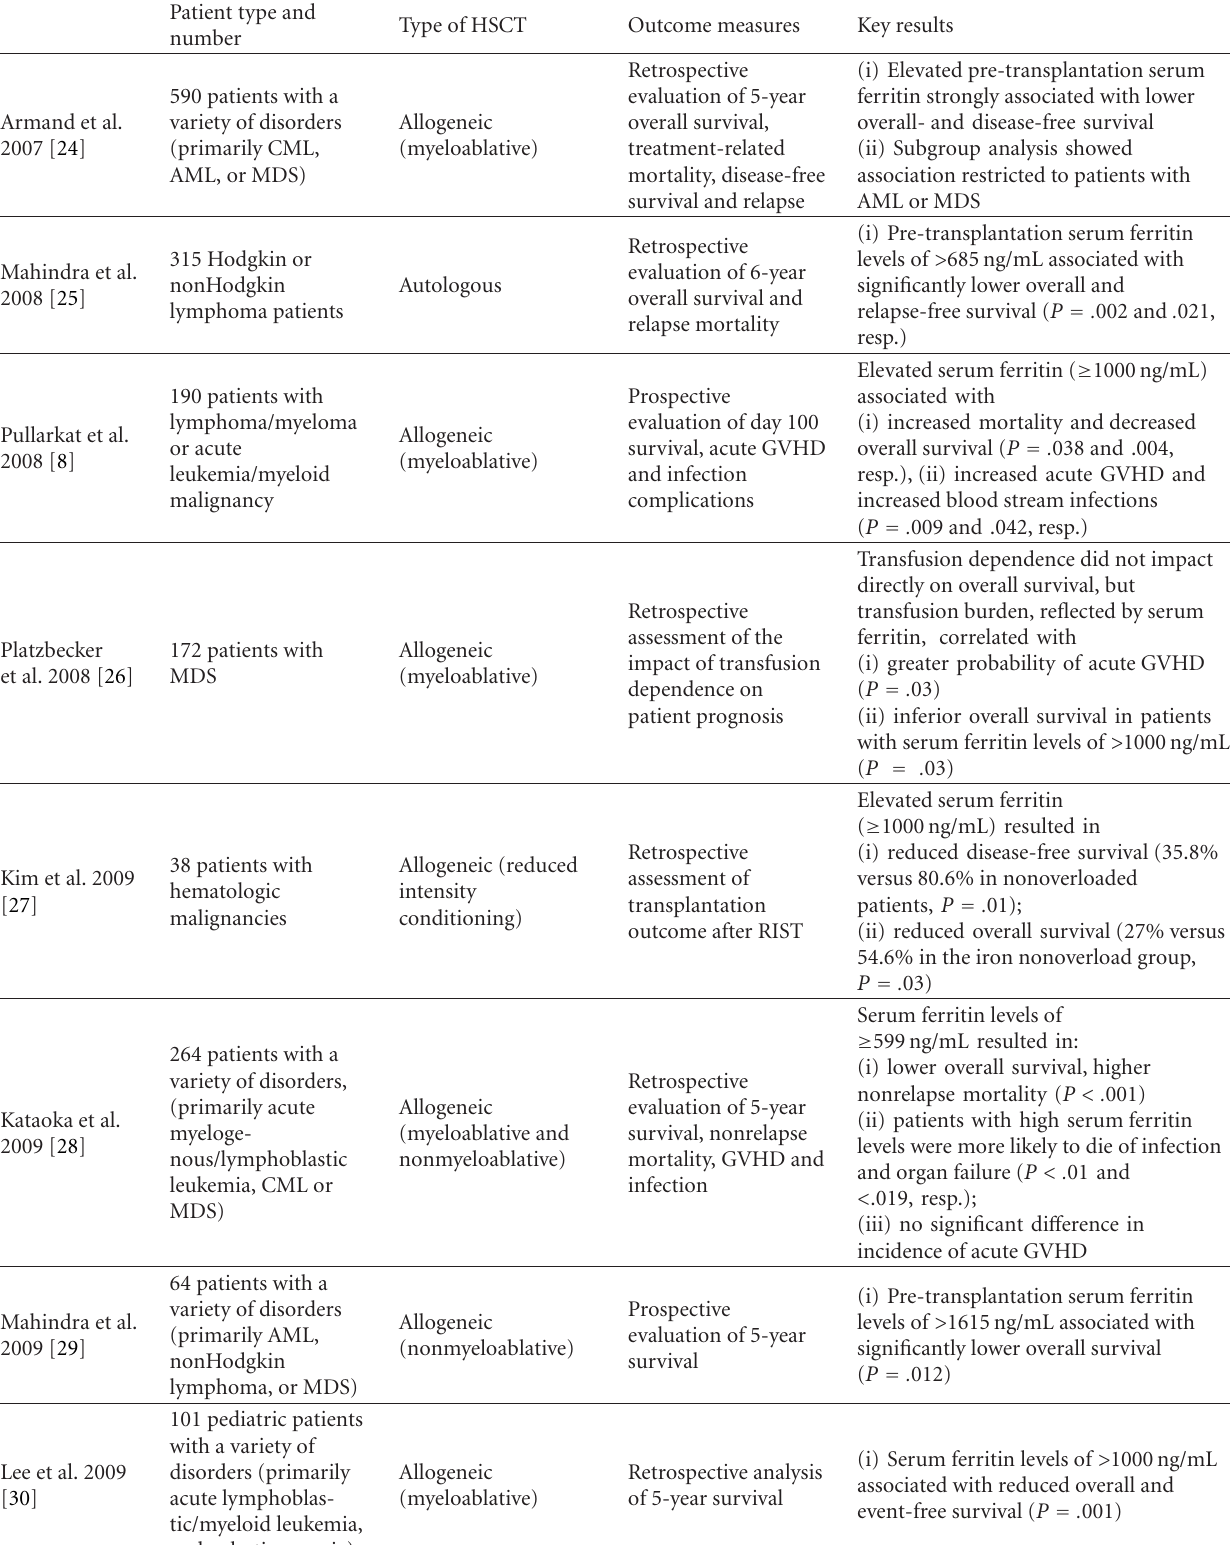
Table 2: Published data showing the impact of pretransplantation serum ferritin levels on survival in HSCT